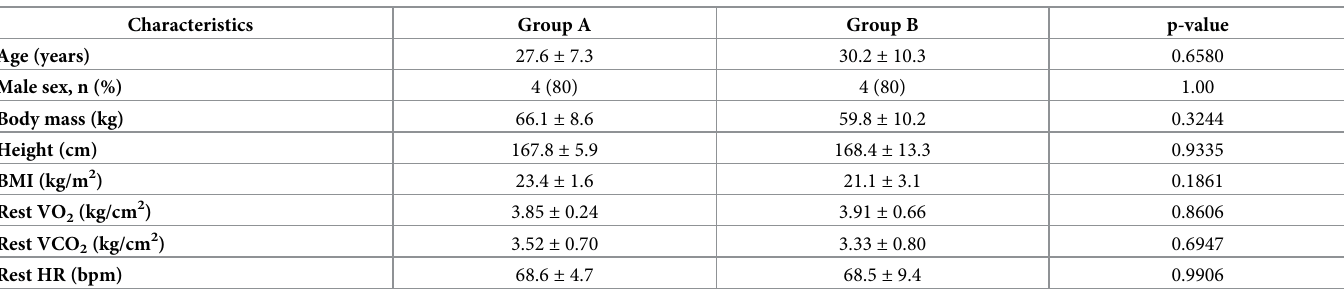
Table 1. Participants’ characteristics.